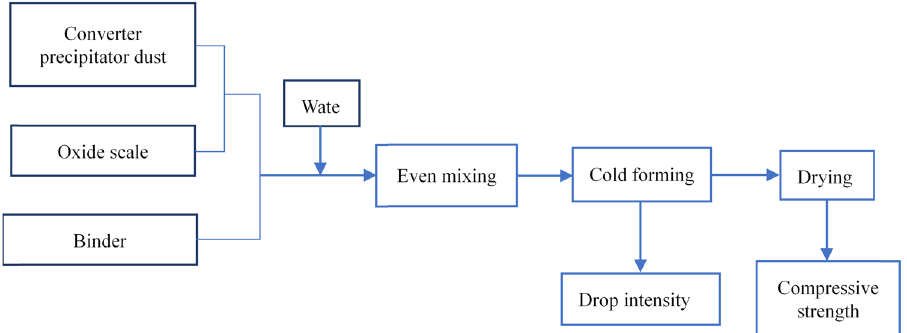
Figure 3: Preparation process of the converter slagging